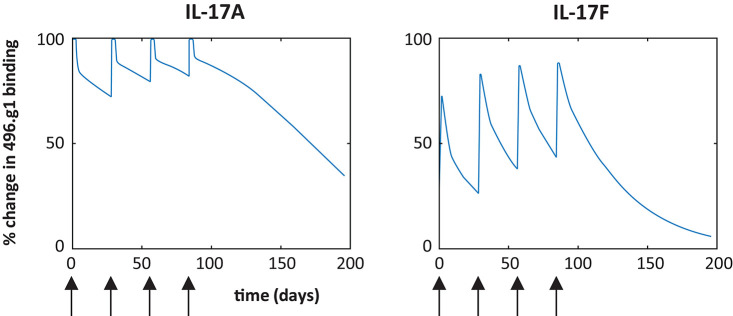
Predicted percentage of IL-17A and IL-17F bound to 496.g1 in psoriatic skin based on a target-mediated drug disposition model. Simulations are based on a 160 mg dose IV every 4 weeks (arrow) and partitioning of 30% of the antibody into the skin and indicate insufficient binding of 496.g1 to completely inhibit IL-17F in psoriatic skin.